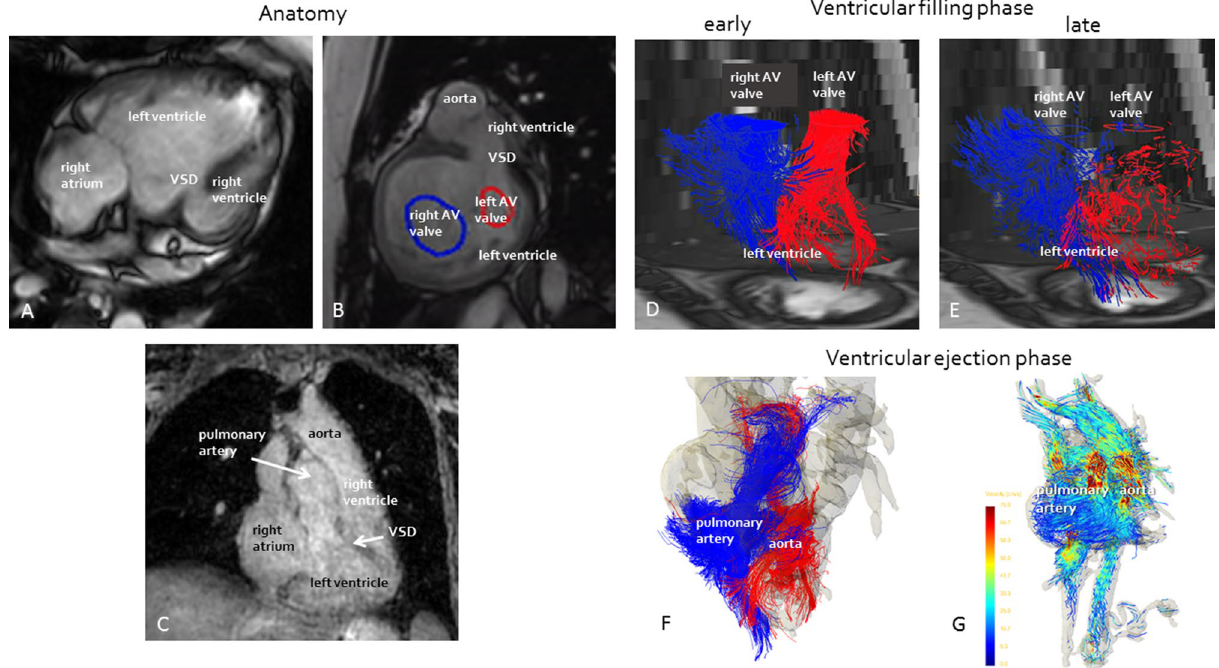
Figure 3. Anatomy and 4D streaming analysis of double inlet left ventricle patient 3. ( A ) 3-chamber view. ( B ) Sagittal view. ( C ) Coronal view. ( D ) Early ventricular filling phase depicting oxygen-poor (blue) blood and oxygen-rich (red) blood streams entering the left ventricle through the right and left atrioventricular valves respectively. ( E ) Late ventricular filling phase depicting oxygen-poor (blue) blood and oxygen-rich (red) blood streams entering the left ventricle through the right and left atrioventricular valves respectively. ( F ) Ventricular ejection phase depicting oxygen-poor (blue) blood and oxygen-rich (red) blood streams entering the pulmonary artery and aorta respectively. Oxygen-poor blood is not ejected in the aorta, blood ejected into the pulmonary artery seems partially oxygen-rich and oxygen-poor. ( G ) Ejection of blood in aorta (left) and pulmonary artery